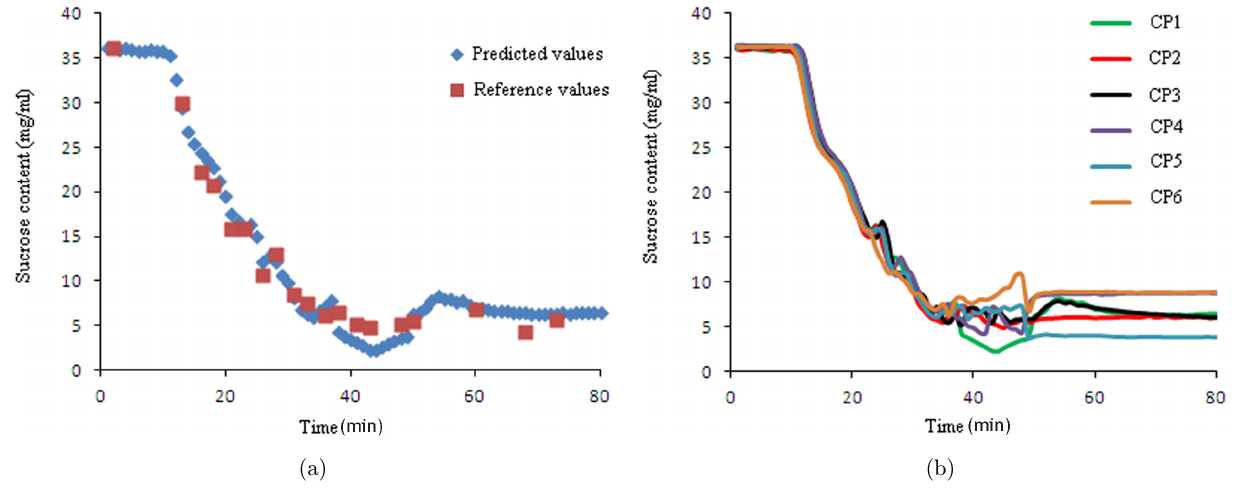
Fig. 4. PLS models for in-line monitoring applications: (a) sucrose prediction during the alcohol precipitation for certain batch runs and (b) process trajectory and evolution of batches for sugar removal based on the six CP